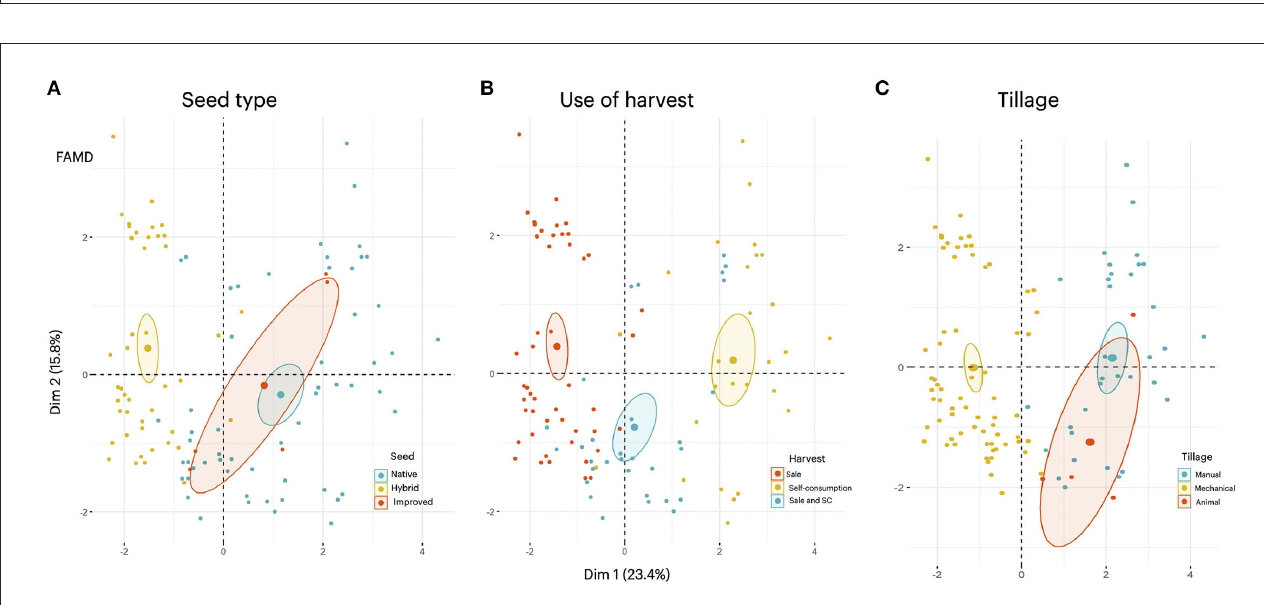
FIGURE4 FAMD for farm typologies. Graphical representation of Mexico highlands plots and their distribution, showing each plot according to the type of property (A) seed type, (B) use of the harvest, and (C) type of tillage. Each dot corresponds to one plot in the field; the color of the dots highlights the categorical variable in the legend; ellipses correspond to confidence ellipses around the mean.